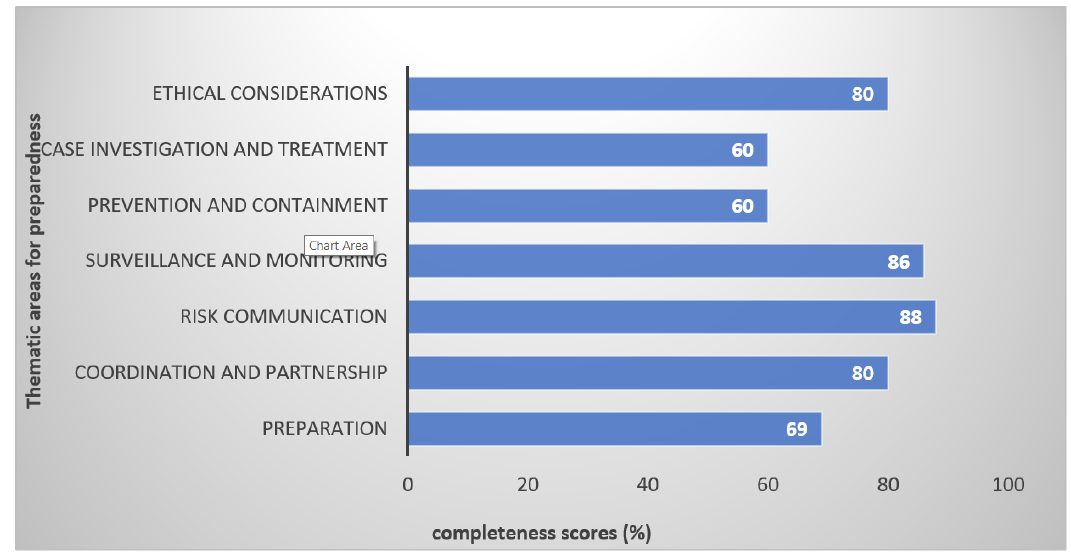
Figure 1. The completeness of Pandemic influenza preparedness plan for